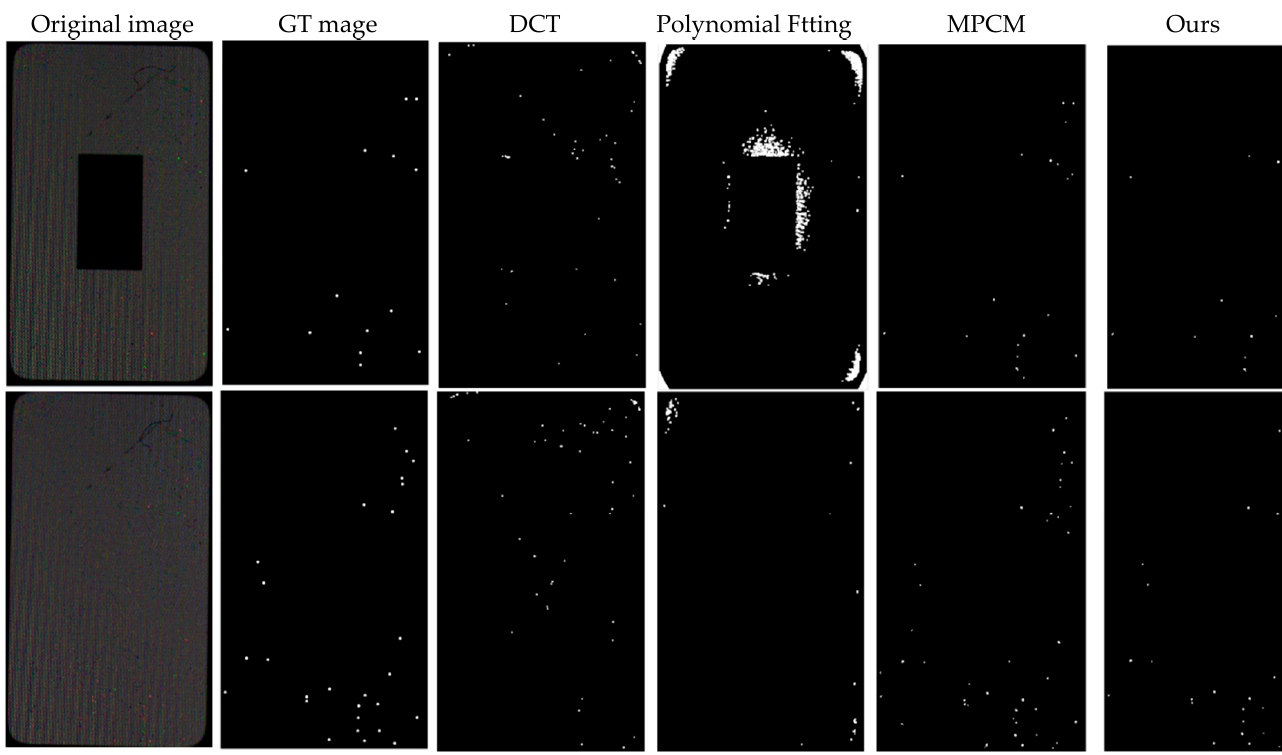
Table 3. Metrics of our proposed method.